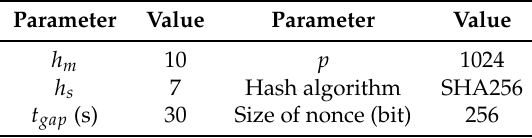
Table 3. MOTP parameter configuration.